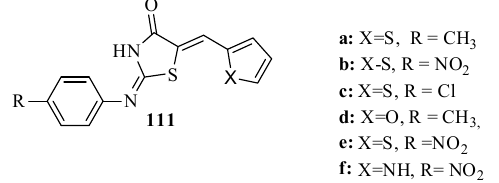
Figure 46. Structure of thiazolidin-4-one derivatives 111a – f .